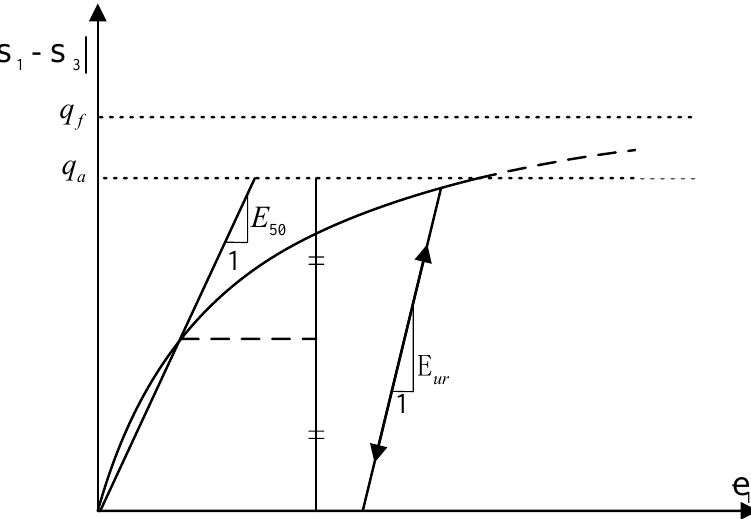
Figure 2. Stress–strain curve of E 50 and E ur . Figure 2. Stress – strain curve of E Figure 2. Stress – strain curve of E 50 and E ur .